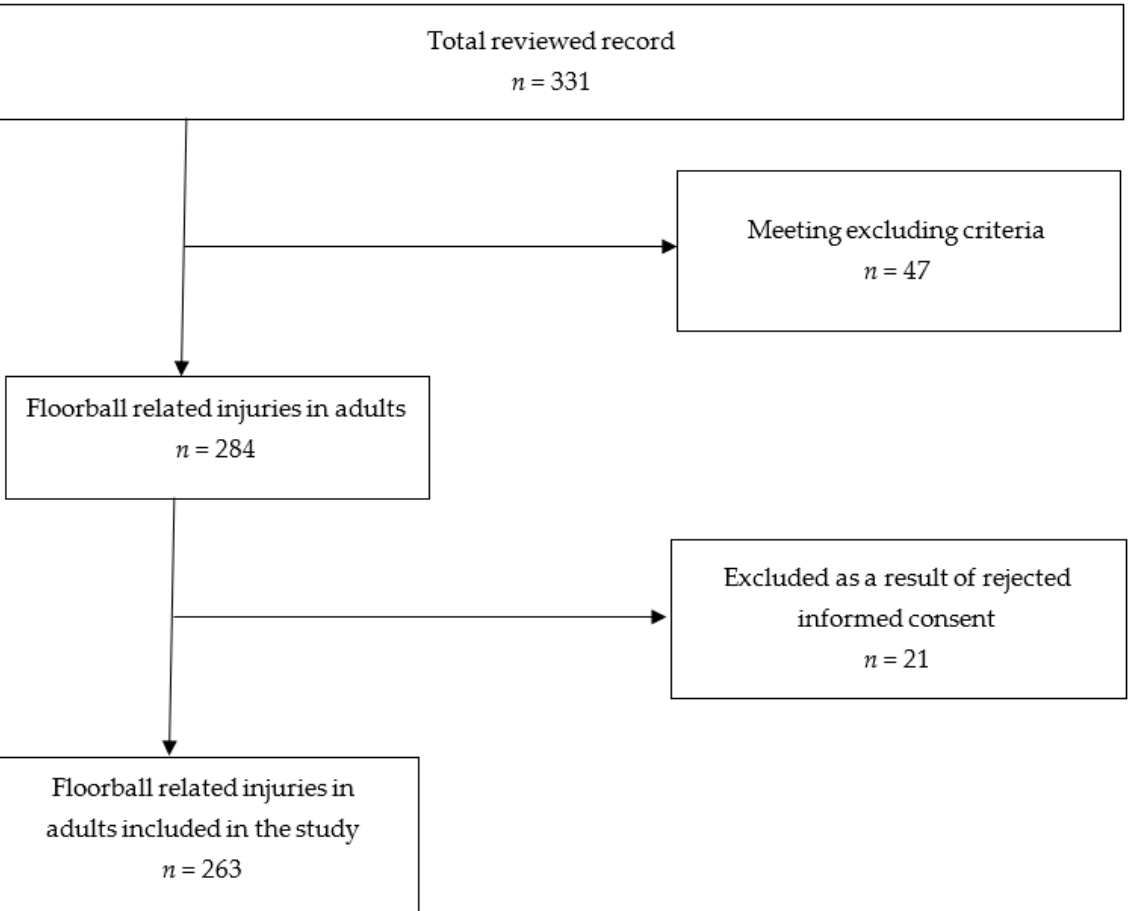
Figure 1. Flow chart of selection of medical records.